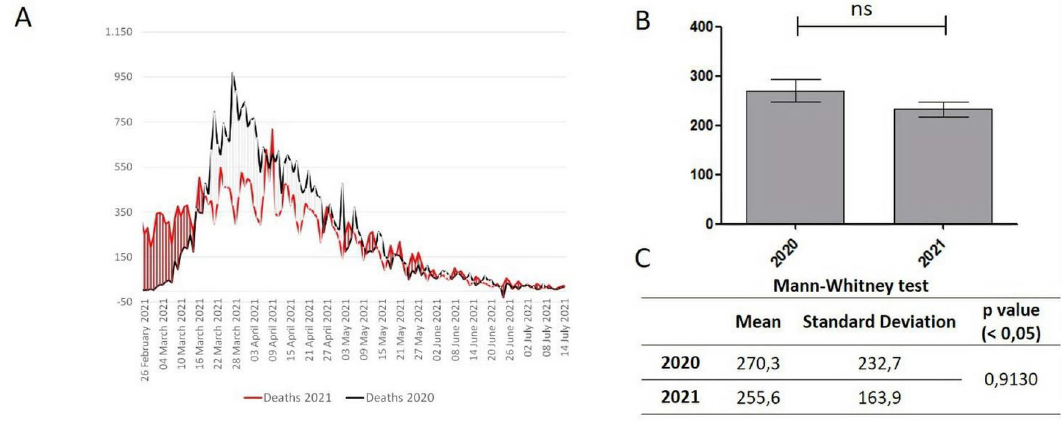
Figure 1. A. Trend of the Deaths variable; B. Significant differences between two periods, with *p < .05; C. Mean, Standard deviation, p